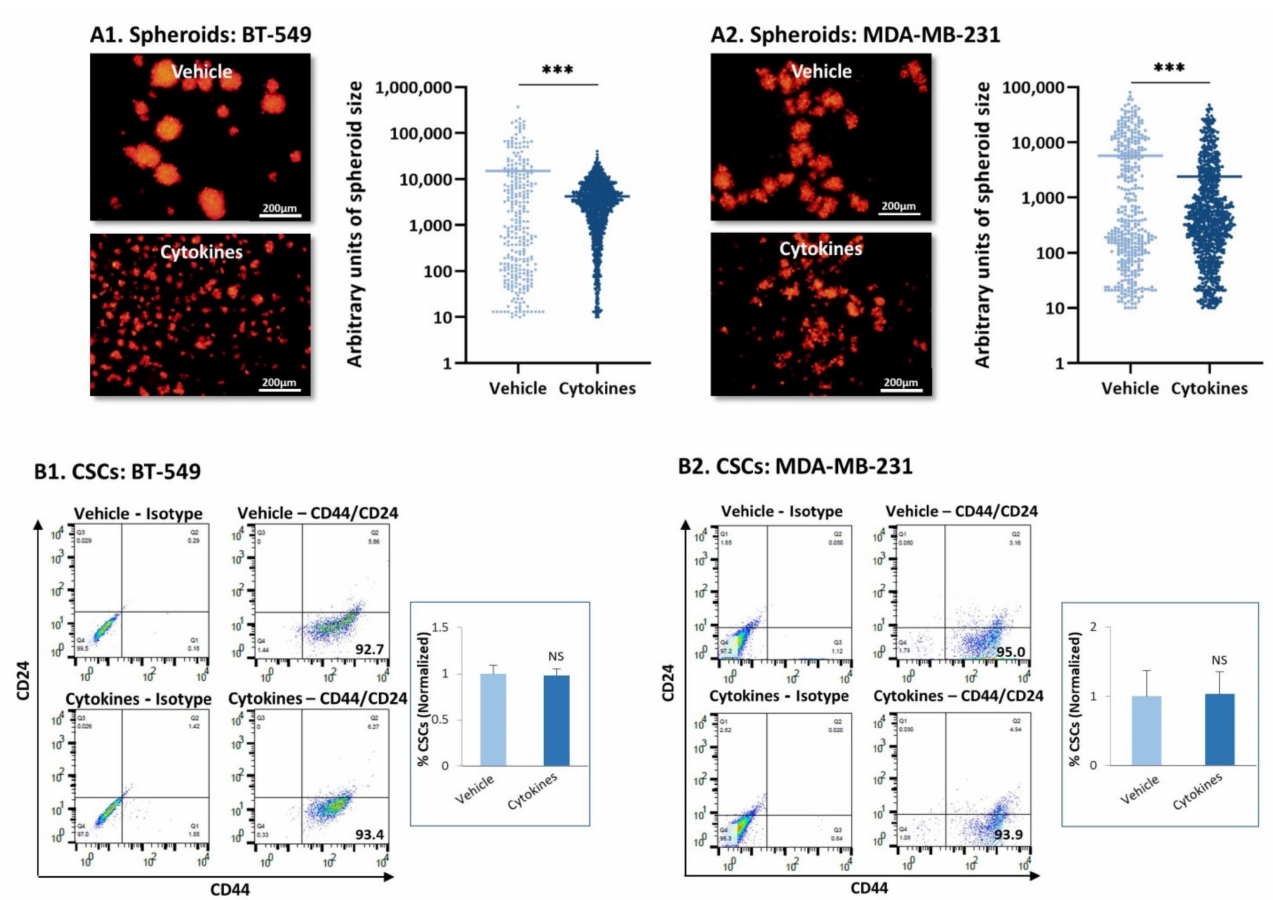
Figure 4. Continuous TNF α + IL-1 β stimulation leads to tumor cell dispersion and does not affect stemness in TNBC cells. ( A ) mCherry-expressing TNBC cells were continuously stimulated by TNF α + IL-1 β , or treated by a vehicle control (as described in Figure 1), and then have been tested for formation of tumor spheroids. ( A1 ) BT-549 cells. ( A2 ) MDA-MB-231 cells. The photos demonstrate the representative patterns of spheroid formation by the cells, at 3 days or 7 days after seeding, for BT-549 cells and MDA-MB-231 cells, respectively. Bar, 200 µ m. The results of a representative experiment out of n = 3 are presented. Spheroid size was quantified by the ImageJ program in 10 fields for each treatment, in each experiment. *** p < 0.001. ( B ) Incidence of CSCs, determined as CD44+/CD24 low/ -cells. ( B1 ) BT-549 cells. ( B2 ) MDA-MB-231 cells. The figure presents flow cytometry plots of a representative experiment, and the graphs demonstrate the average ± SD of normalized values of CD44+/CD24 low/ -cells in n = 3 experiments; the levels of CSCs in vehicle-treated cells that were identified in the different experiments were given the value of 1. NS, not